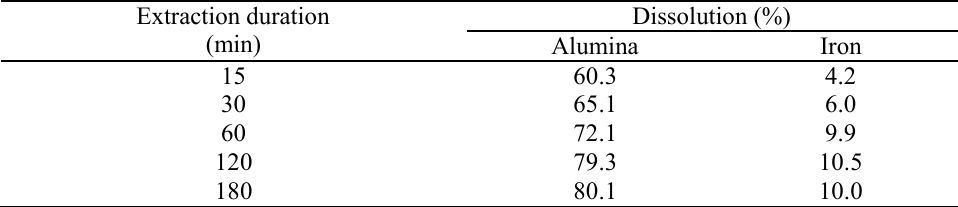
Table 4. Effect of extraction time on the dissolution of alumina and iron from clay